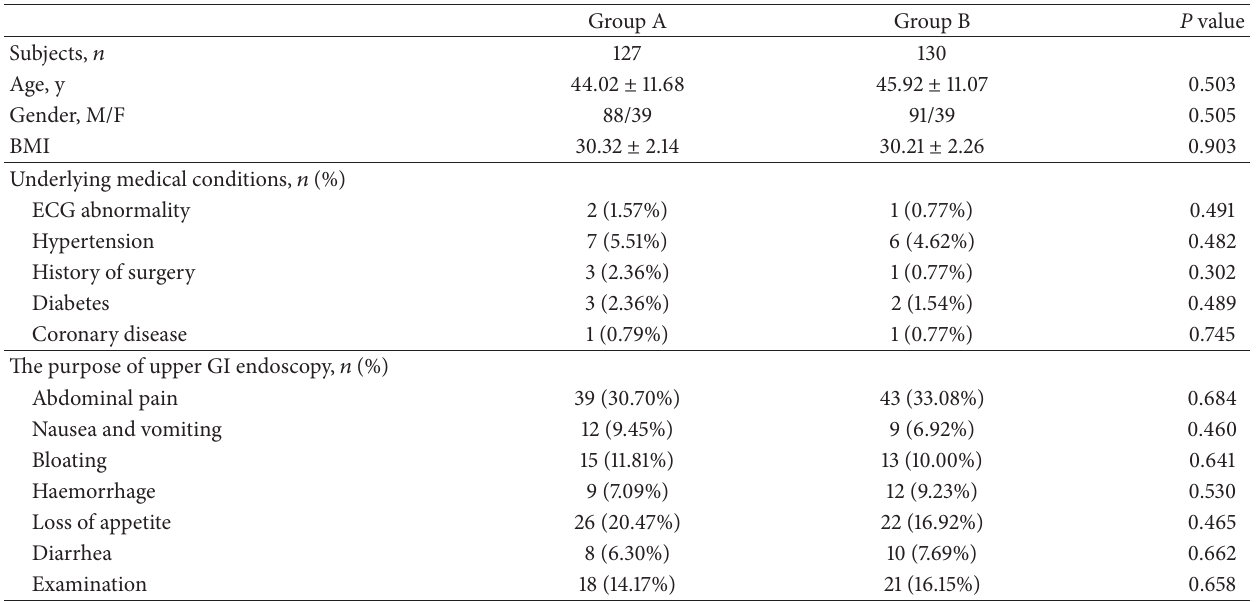
Table 1: Baseline characteristics of patients in Groups A and